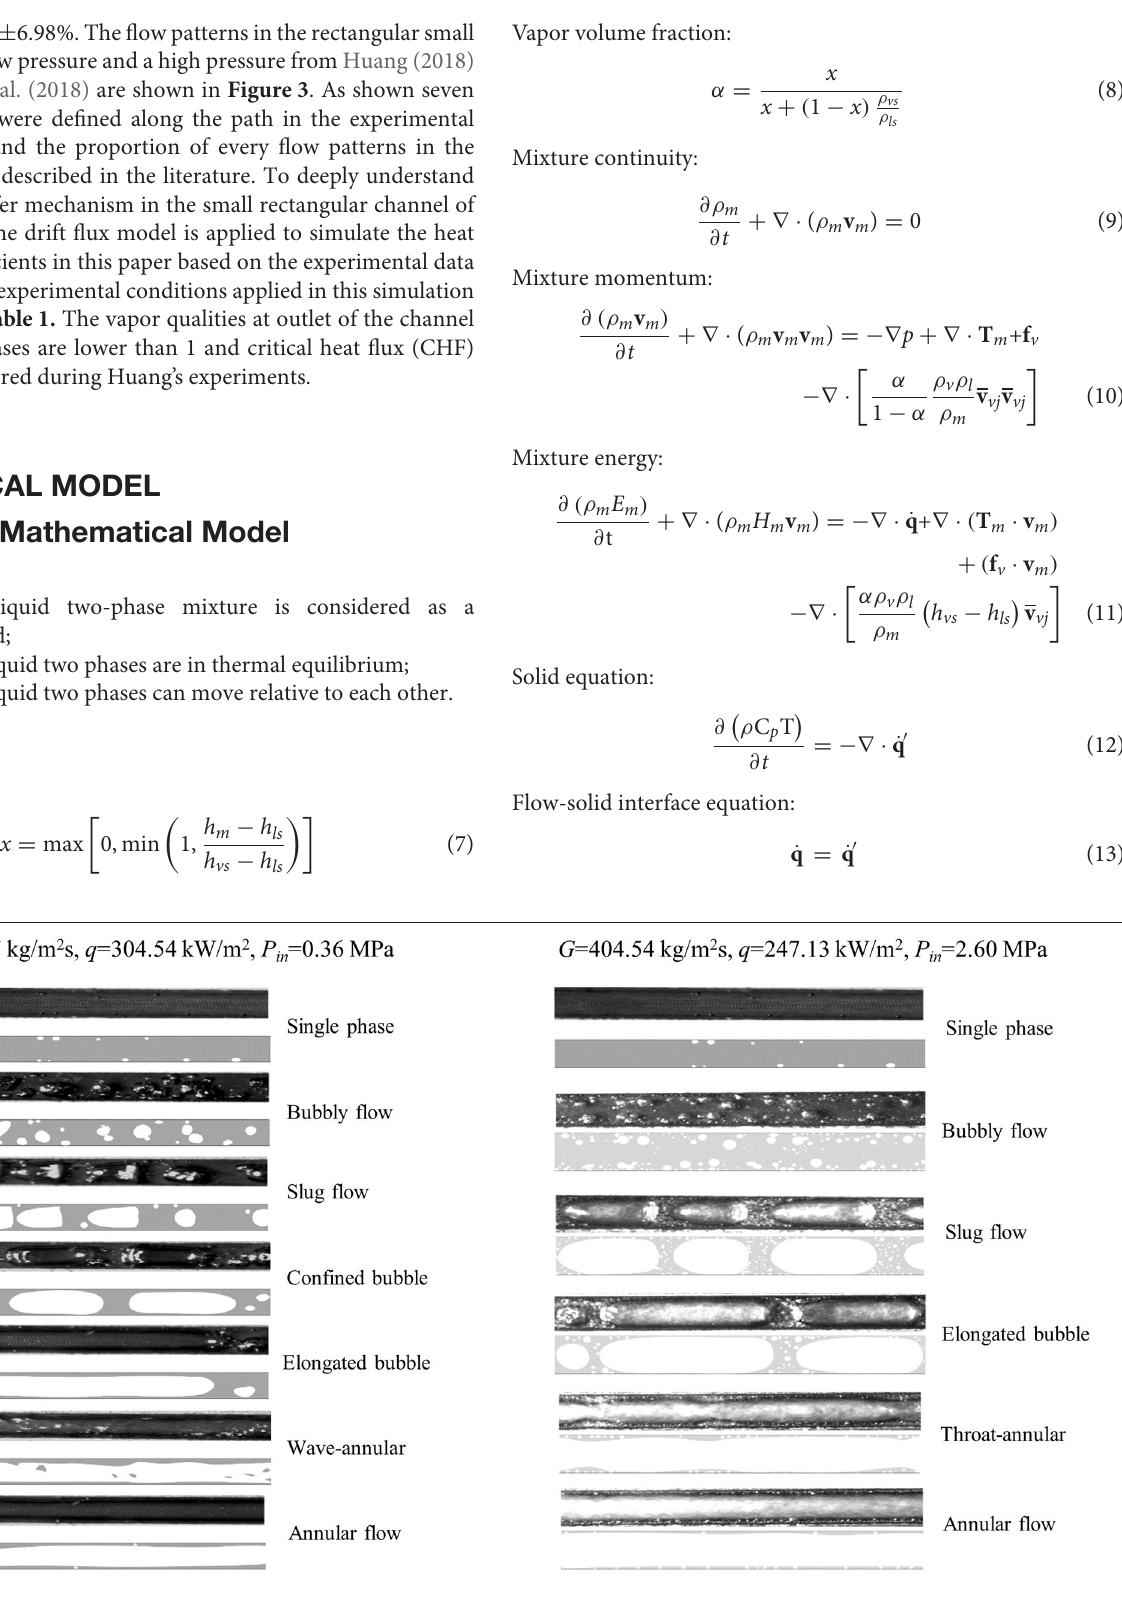
FIGURE 3 | The flow patterns in the rectangular small channel at a low pressure and a high pressure.